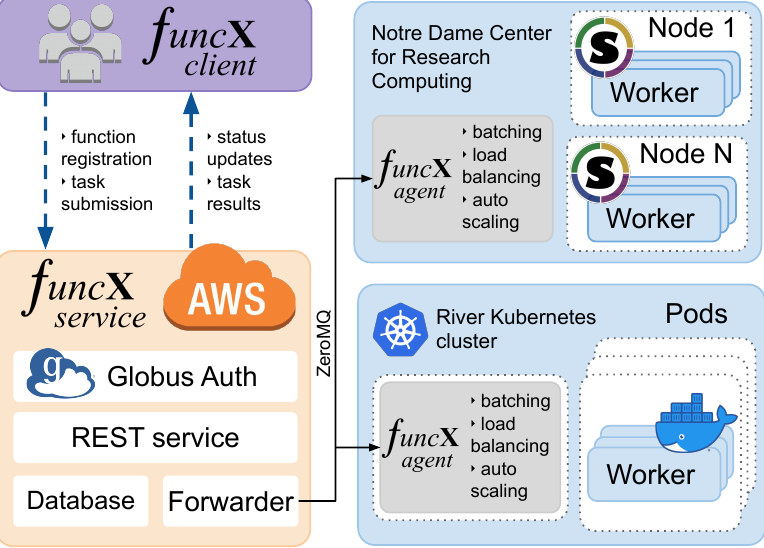
Figure 1. Overview of the funcX system architecture. The The funcX client abstracts inteactions with funcX. The funcX service is used to register and manage endpoints, register and execute functions, and retrieve results. FuncX endpoints are deployed on remote computers (in this case at Notre Dame and the River Kubernetes cluster) and enable function execution on provisioned nodes, optionally using locally supported